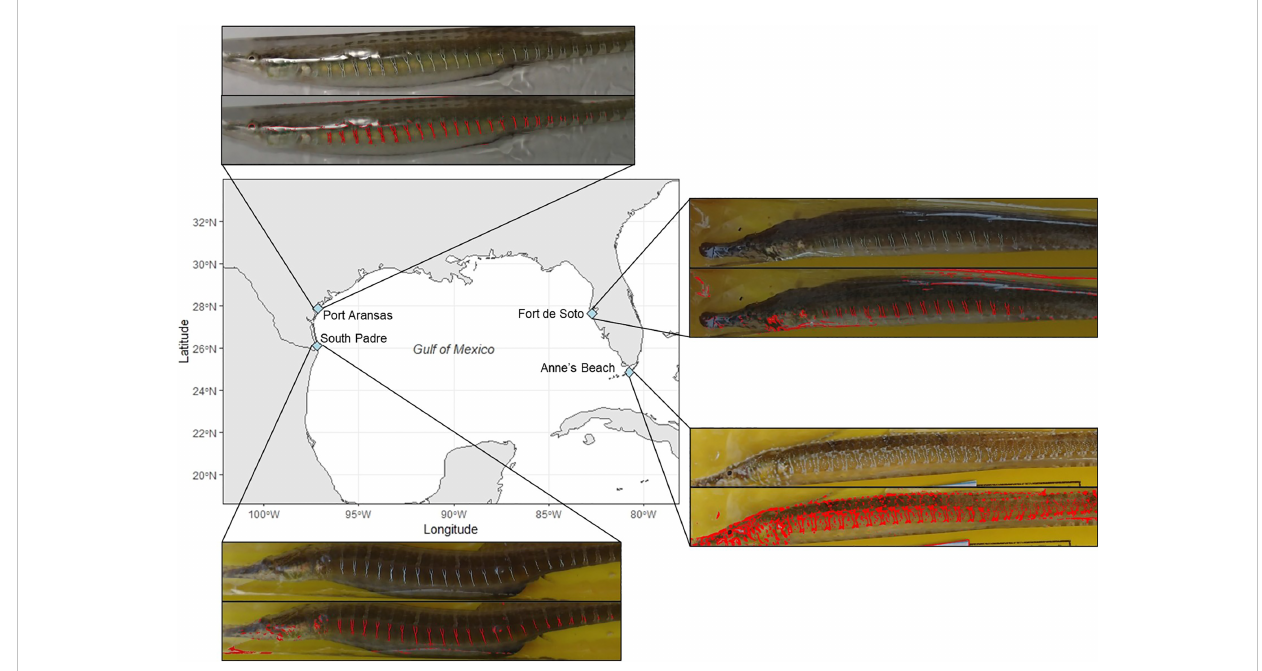
FIGURE 2 A map of the four geographic sites chosen to analyze for this study from Flanagan et al. (2016). For each location, there is a photo of a female S. scovelli collected at that site (top) paired with that same photograph after being processed through the Iridescence Detection and Isolation Algorithm (IDIA) (bottom). The red colouration in these photographs represents areas distinguished as iridescent by the IDIA. Due to limitations in the fi eld all photos were taken in various lighting conditions. However, we conducted experiments under varied lighting conditions and found that iridescence does not signi fi cantly differ in response to lighting (Figure